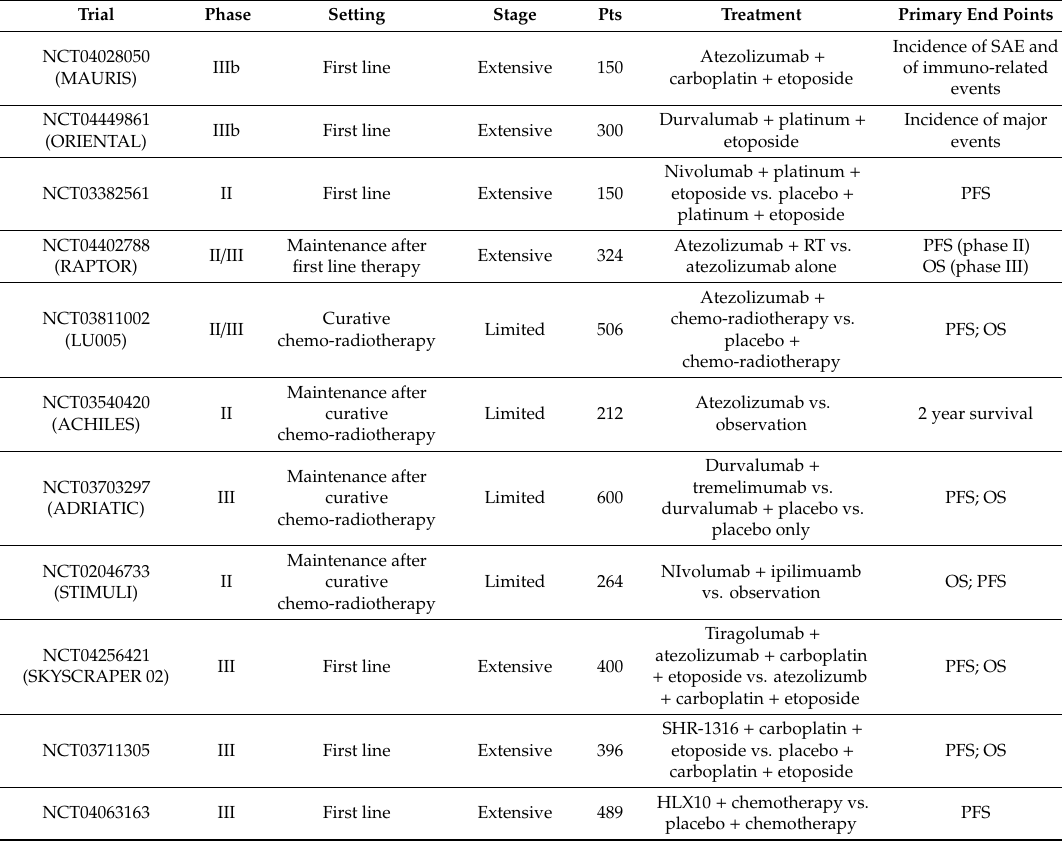
Table 3. Ongoing trials with checkpoint inhibitors in